Question: Write the caption for this figure.
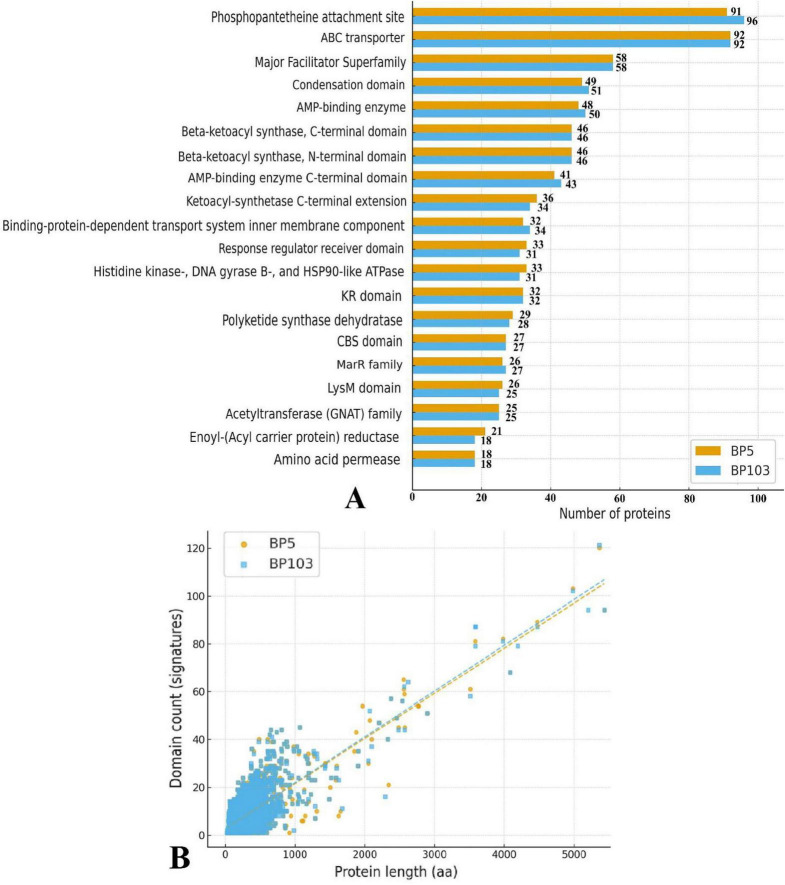
Answer: Protein domain characteristics between B. velezensis BP5 and BP103. (A) Comparison of Top 20 Pfam Domains between B. velezensis BP5 and BP103. (B) Scatter Plot Comparing Protein Length and Domain Count in BP5 and BP103.